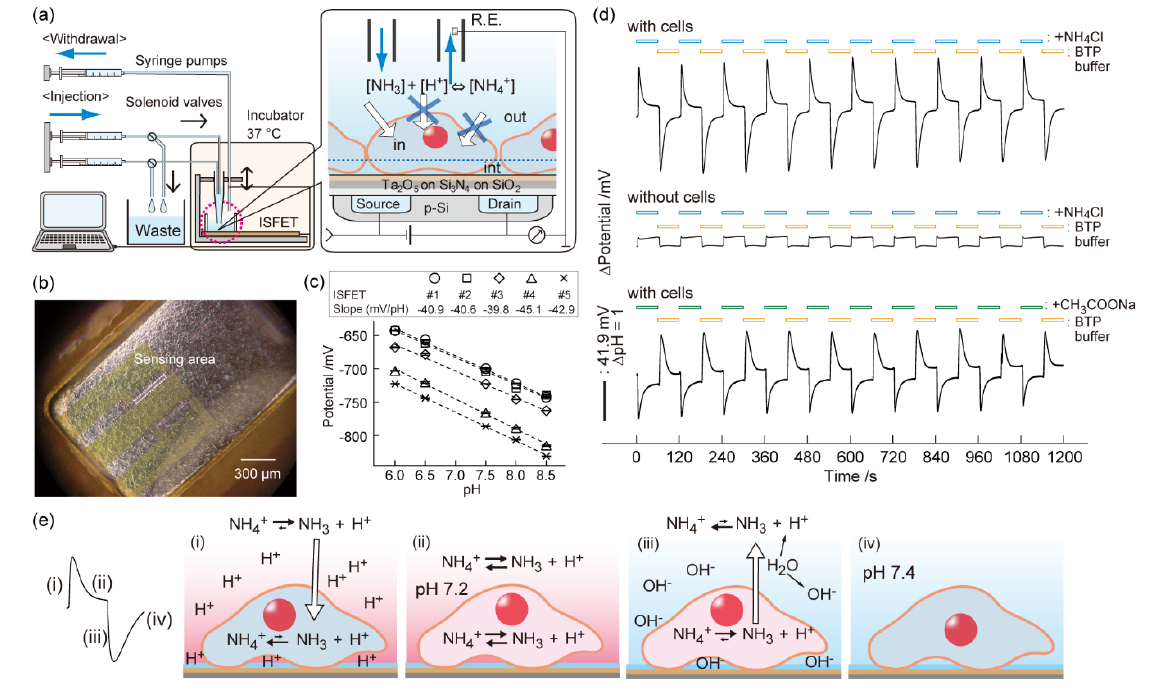
Figure 1. Cell/ISFET system. ( a ) HepG2 cells were cultured on the poly-L-lysine-coated gate insulator of the pH-sensing transistor at subconfluent levels. An automated fluidic system comprising syringe pumps and solenoid valves achieved instant exchange of the solutions surrounding the cells. The inset shows the mass transfer of NH 4+ , NH 3 , and H + between the bulk phase, cells/ISFET interspace, and intracellular compartment, respectively, and the ammonia equilibrium reaction in each phase. The semi-permeability of the cell membranes prevented the passive diffusion of charged species into the cells. ( b ) Phase contrast image of HepG2 cells on the gate insulator. ( c ) The Nernst pH response of the ISFET with HepG2 monolayers ( n = 5). ( d ) Time course of the ISFET potential during periodic flushes (1 min each) of isotonic buffers containing 10 mM (NH 4 Cl), (CH 3 COONa), or 20 mM (sucrose). A pH overshoot occurred when the buffer solution surrounding the cells was exchanged stepwise. The direction was opposite for CH 3 COONa. No pH overshoots occurred in the absence of cells on the gate insulator. ( e ) Schematic illustrations explaining the mechanism of local pH changes during the periodic flushes of NH 4 Cl in the extracellular space. Reproduced with modification from [46] with permission by Elsevier.